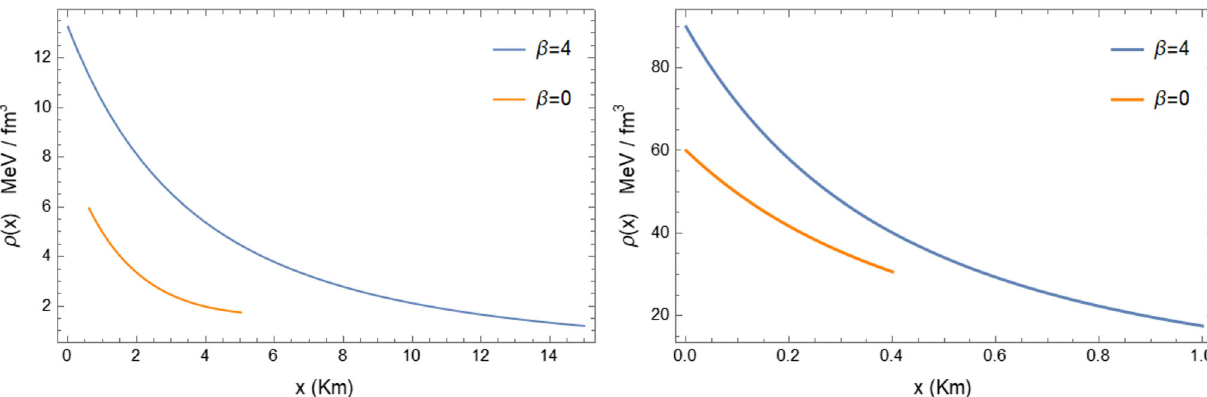
Fig. 1 The pressure profile is plotted as a function of radius for Vidya– Tikekar (VT) and Finch–Skea (FS) metric potential for β = 4 and 0, respectively. For left diagrams the chosen values are a = 7 , b =